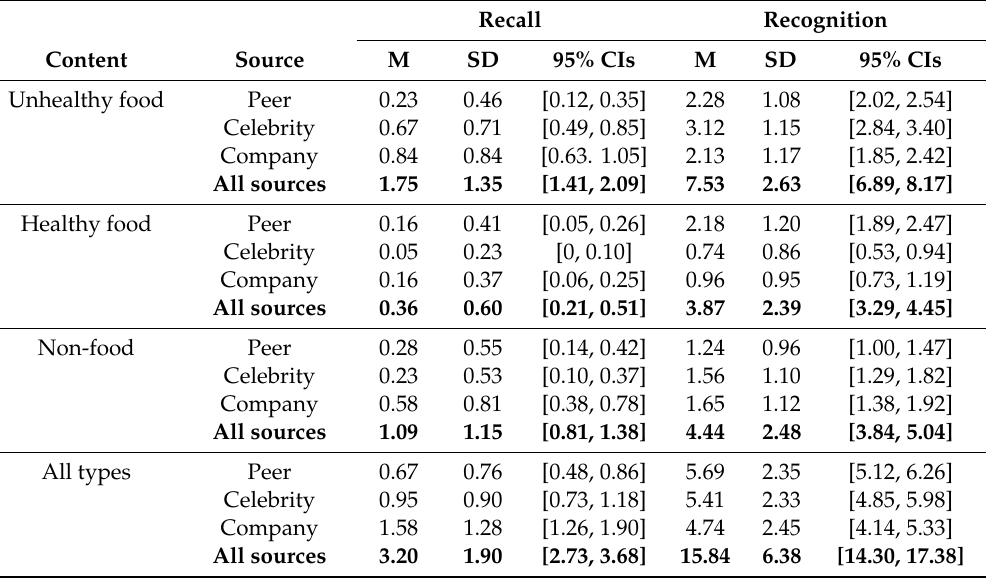
Table 5. Recall and recognition: Means, standard deviations, and 95% confidence intervals for recalled and recognised brands. Recall